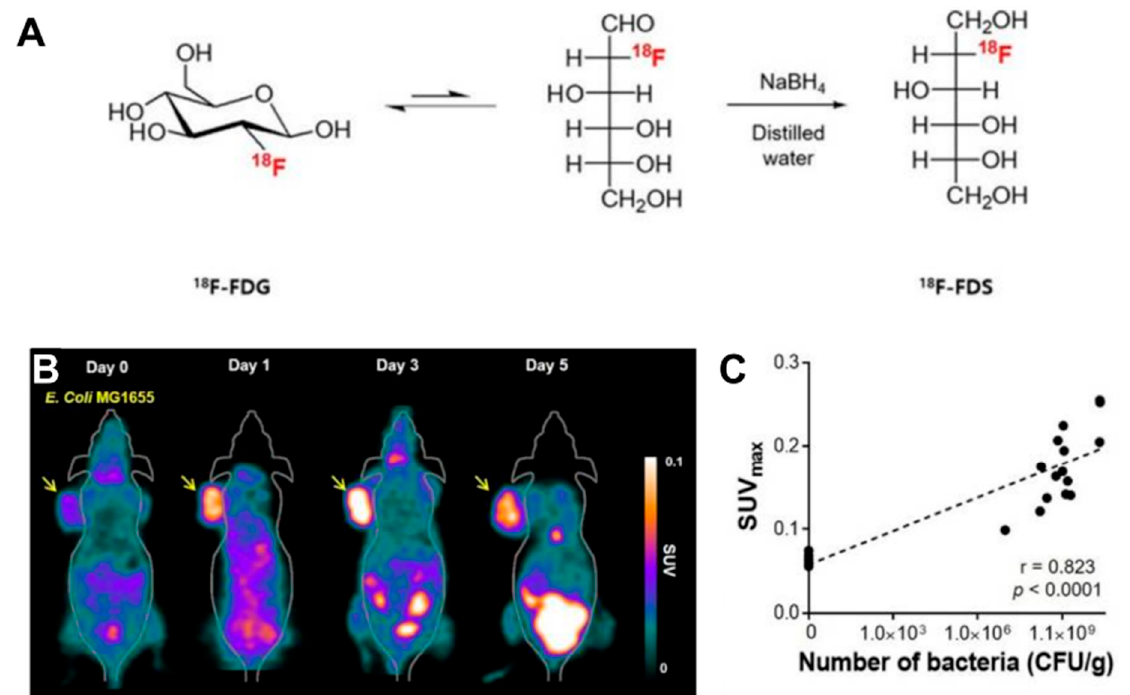
Figure 2. ( A ) [ 18 F]-FDS PET imaging in CT26-bearing mice treated with E. coli. ( A ) PET imaging was performed at day 0, 1, 3, 5 after intravenous injection of E. coli. The radioactivity uptake of the tumor was significantly higher at day 1, 3, 5 than in pre-treatment. ( B ) Positive correlation between SUV max and the number of viable bacteria. ( C ) Schematic illustration of the synthesis of [ 18 F]-FDS from [ 18 F]-FDG. Reproduced with permission from Jung-Joon Min, Theranostics ; published by Ivyspring International Publisher, 2020.